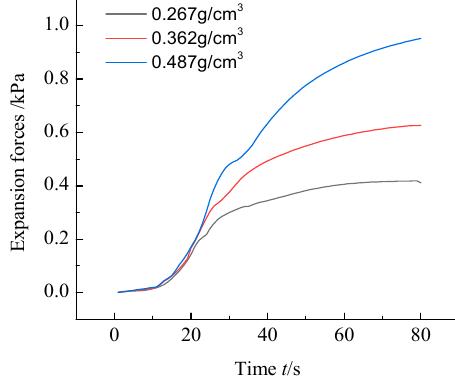
Figure 3. Expansion force-time relationship curves of di ff erent densities.